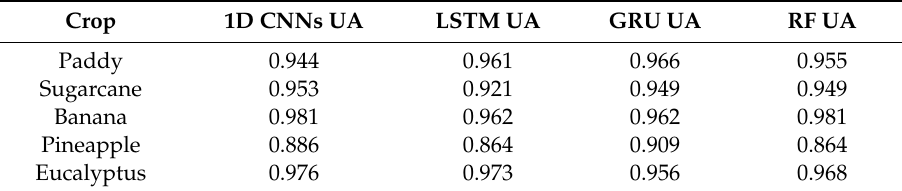
Table 6. User’s accuracy (UA) on the time series data with the maximum OAs. Bolded values are the best performances (UA) of each crop type in di ff erent classifiers.